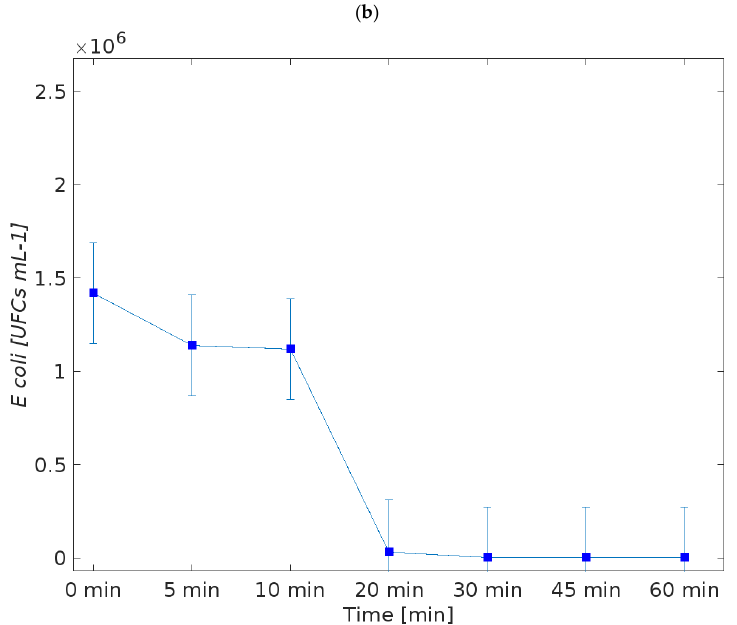
Figure 3. Killing-time curves of ( a , b ), the sample functionalized with HKUST-1 against S. aureus and E. coli bacteria, for up to 60 min of culture. Data derived from two repetitions (means S.D.) according to standards. Positive controls for each bacterium (growth without agent) were also conducted, reaching maximum values of 4.23 × 10 5 and 2.1 × 10 5 CFUs mL −1 for S. aureus bacteria agent-free solution and values of 0.98 × 10 6 and 1.24 × 10 6 CFUs mL −1 for E. coli bacteria agent-free solution, after 1 h (data not shown in graphic).